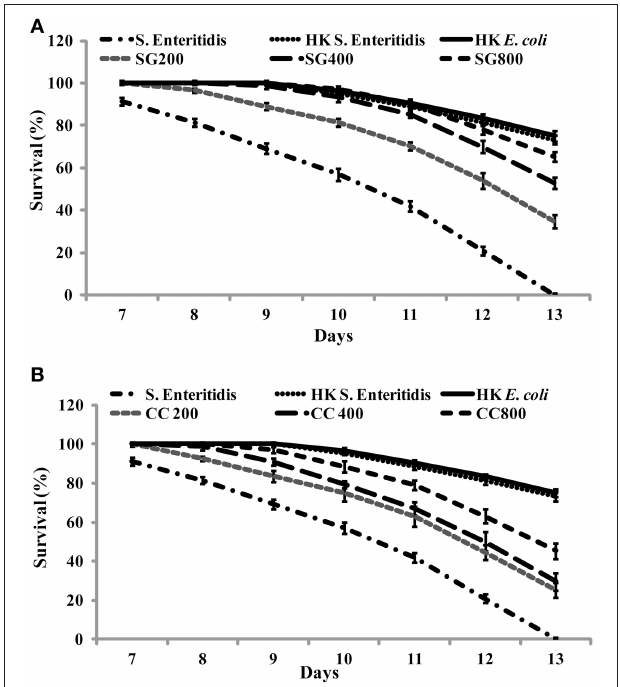
FIGURE 7 | The effect of SWE on the survival of nematodes infected with S. Enteritidis. Three concentrations of SWE (200, 400, and 800 µ g/ml) were used with. Worms were grown with seaweed water extract as food supplements and were exposed to S. Enteritidis. (A) SG treatment and (B) CC treatment. Values represent Mean ± Standard deviation from two experiments with six biological replicates.